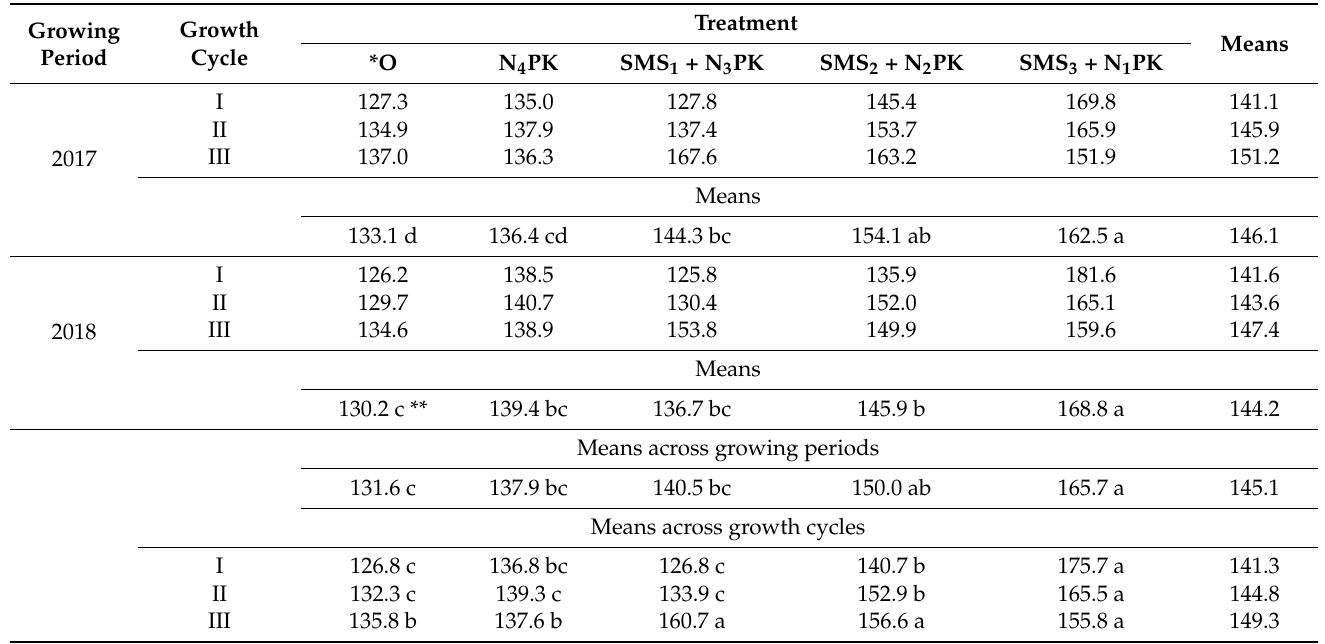
Table 3. The effect of fertilizer treatment, growing period and growth cycle on Festulolium braunii total protein content (g · kg − 1